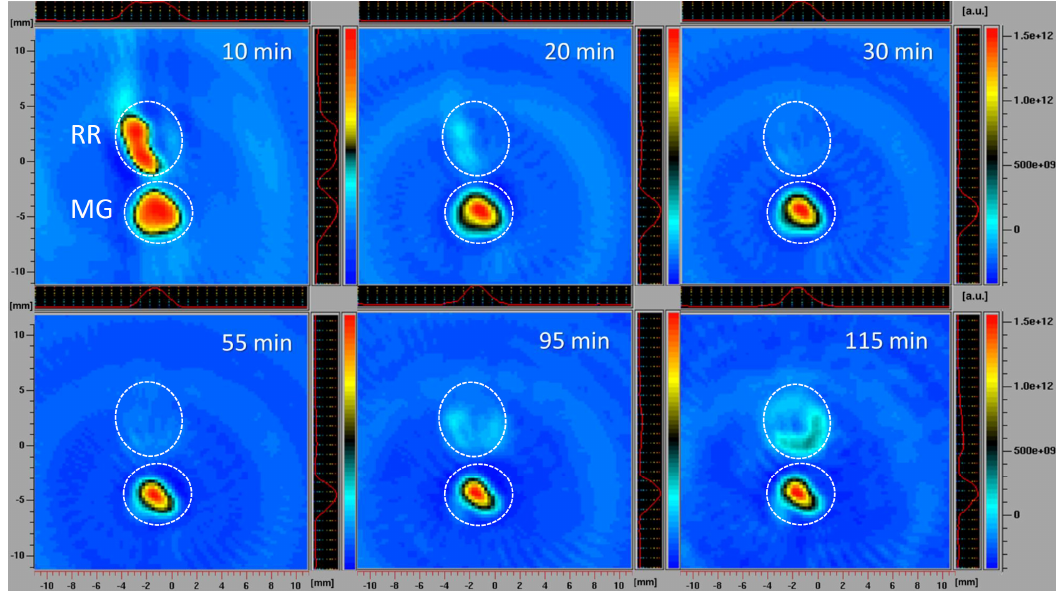
Figure 6. X − band 2D EPR images of slices of MG and RR bittersweet fruits recorded 10, 20, 30, 55, 95, and 115 min after the administration of the spin probe. The upper signal relates to the ripe red (RR) and the lower to the mature green (MG) bittersweet fruits. The signal amplitude in arbitrary units is shown in the form of color scales, which represent the intensities/concentrations of the 3CP spin probe in samples, with the red color indicating the zones/tissues with the highest content of 3CP in the form of nitroxyl radical. The black/green colors indicate tissues with lower levels of 3CP in the form of nitroxyl radical. MG fruits were treated with 2 mM 3CP, and RR fruits with 15 mM 3CP.